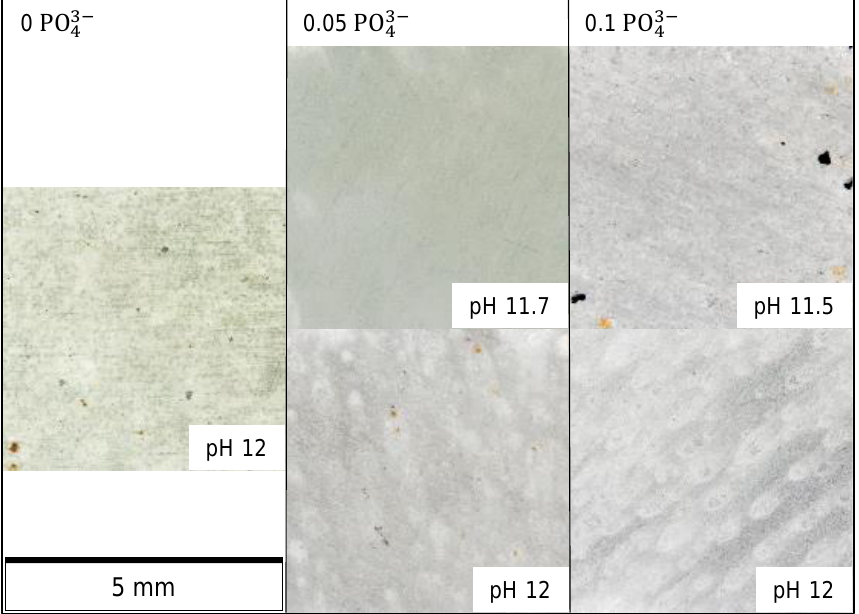
Figure 5. Optical microscopic images of the sample areas after polarization at constant potential (OCP + 4 V) in the different electrolytes, categorized by the phosphate content in the electrolyte ( PO 4 3− ) in mol / L and the pH. The scale bar applies to all images.